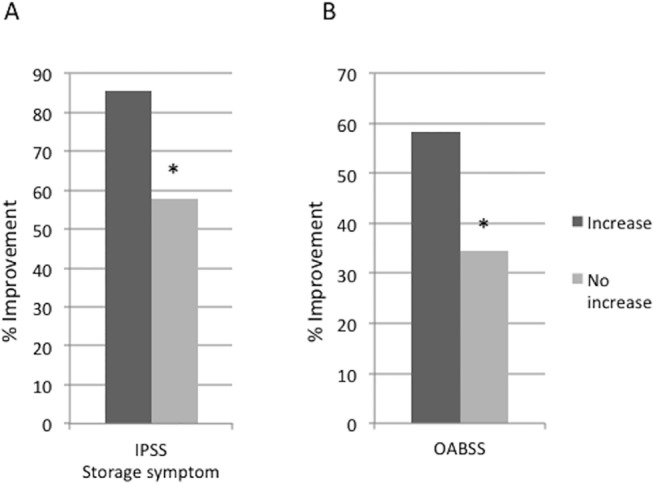
The improvement rate of IPSS and OABSS.(A) shows the improvement rate of storage symptoms in IPSS for both the increased perfusion group and the no change group. (B) shows the improvement rate of OABSS storage symptoms for the increased perfusion group and the no change group.*: p<0.001 Student’s t-test